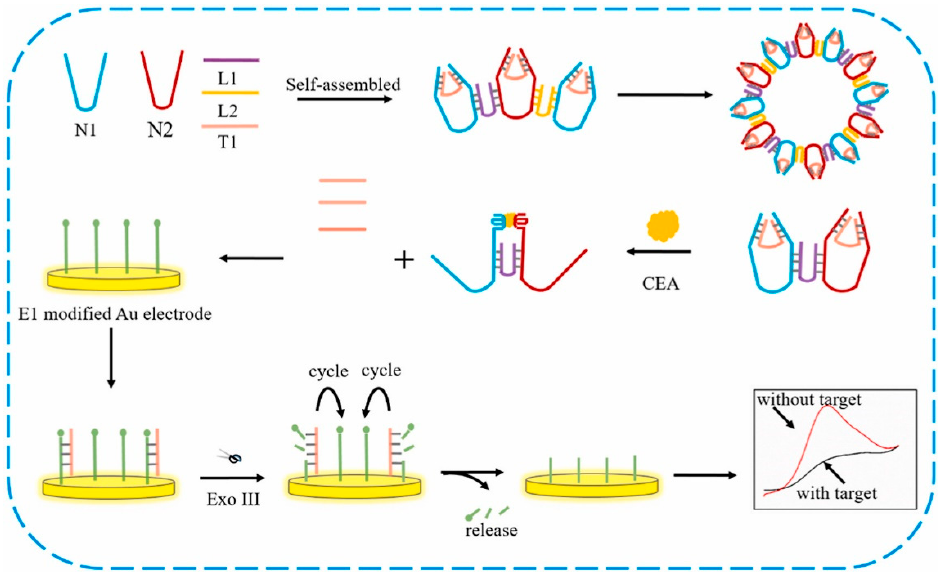
Figure 5. Schematic representation of label-free 3D DNA nanoprobe DNA tweezers-based electrochemical sensor for the detection of carcinoembryonic antigen (CEA) biomarker. Reproduced with the permission [227].Copyright 2018, Elsevier.